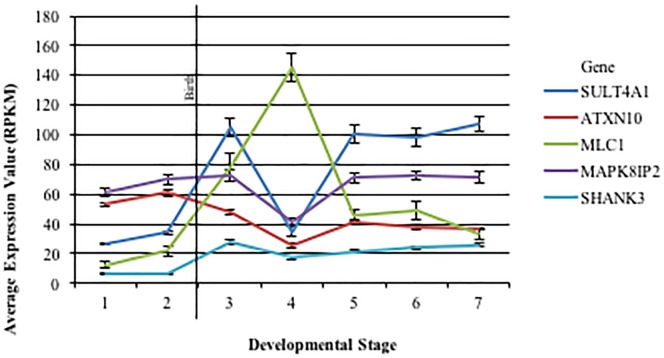
Average expression across developmental time.The average expression of each gene assessed across seven developmental stages is shown (1: 16 pcw– 17 pcw, 2: 19 pcw– 24 pcw, 3: 4 mos– 1 yr, 4: 2 yrs– 4 yrs, 5:8 yrs– 13 yrs, 6: 15 yrs– 21 yrs, 7: 23 yrs– 40 yrs). Error bars represent the standard error of the mean. pcw = post-conception years; mos = months; yrs = years.